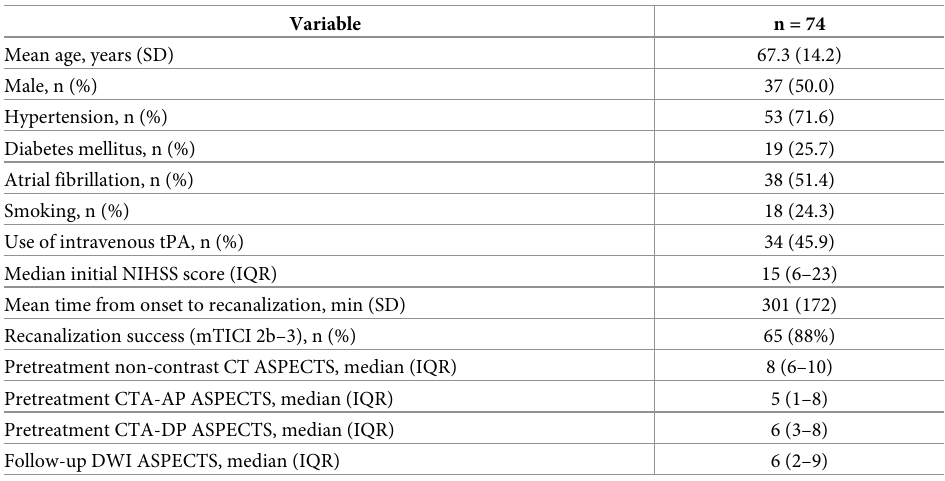
Table 1. Patient demographics and